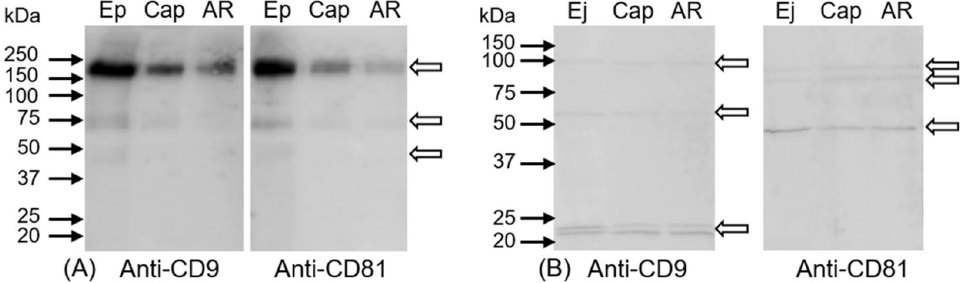
Figure 7. Detection of CD9 and CD81 tetraspanins in mouse ( A ) and human ( B ) sperm extract under non-reducing conditions (5 × 10 6 sperm cells per lane); Ep—epididymal, Ej—ejaculated, Cap— capacitated, and AR—acrosome-reacted spermatozoa. White arrows indicate antibody reaction. As negative control, blots were incubated with rabbit immunoglobulins. Blots were completely negative.